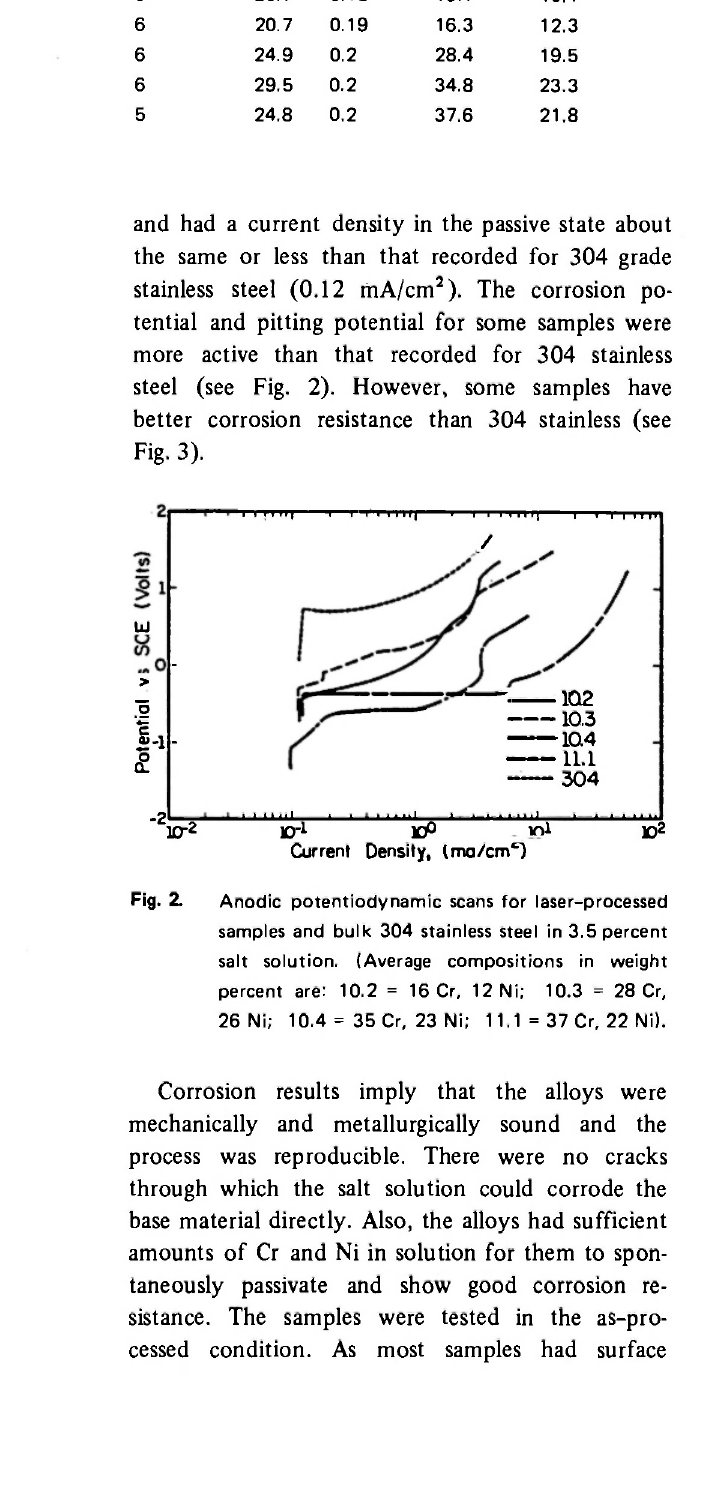
Fig. 3. Anodic potentiodynamic scans for laser-processed samples and bulk 304 stainless steel in 3.5 percent salt solution. (Average compositions in weight percent